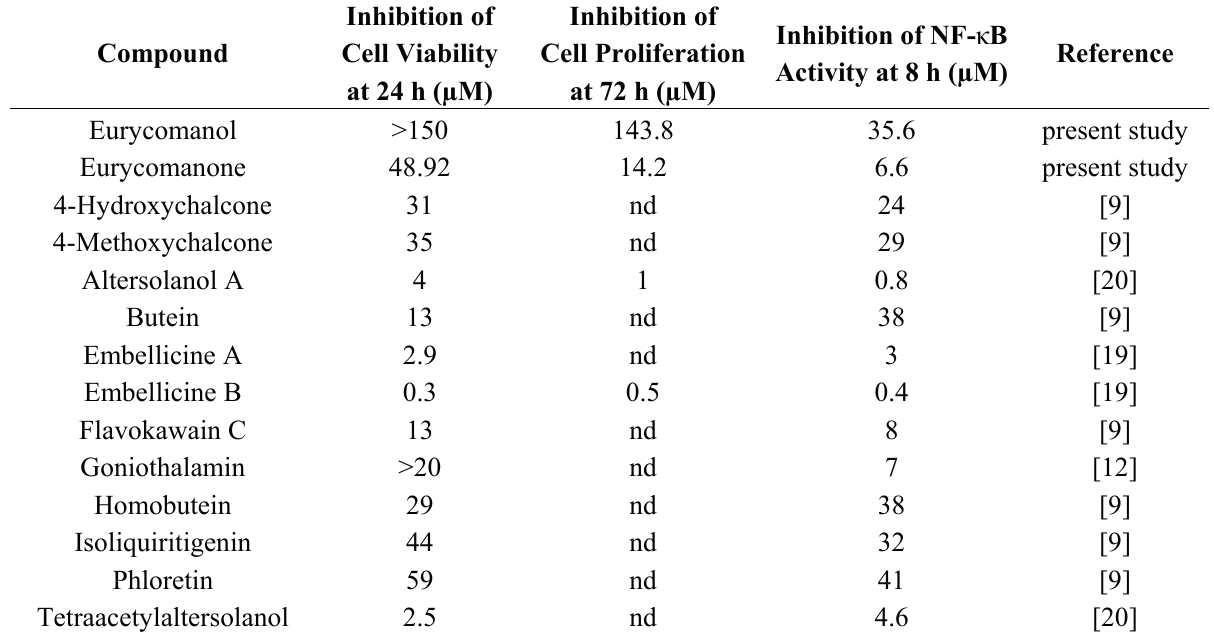
Table 3. Comparison of the effect of eurycomanol and eurycomanone on inhibition of viability, proliferation and NF- κ B activity. IC 50 values were measured in K562 cells after the indicated treatment